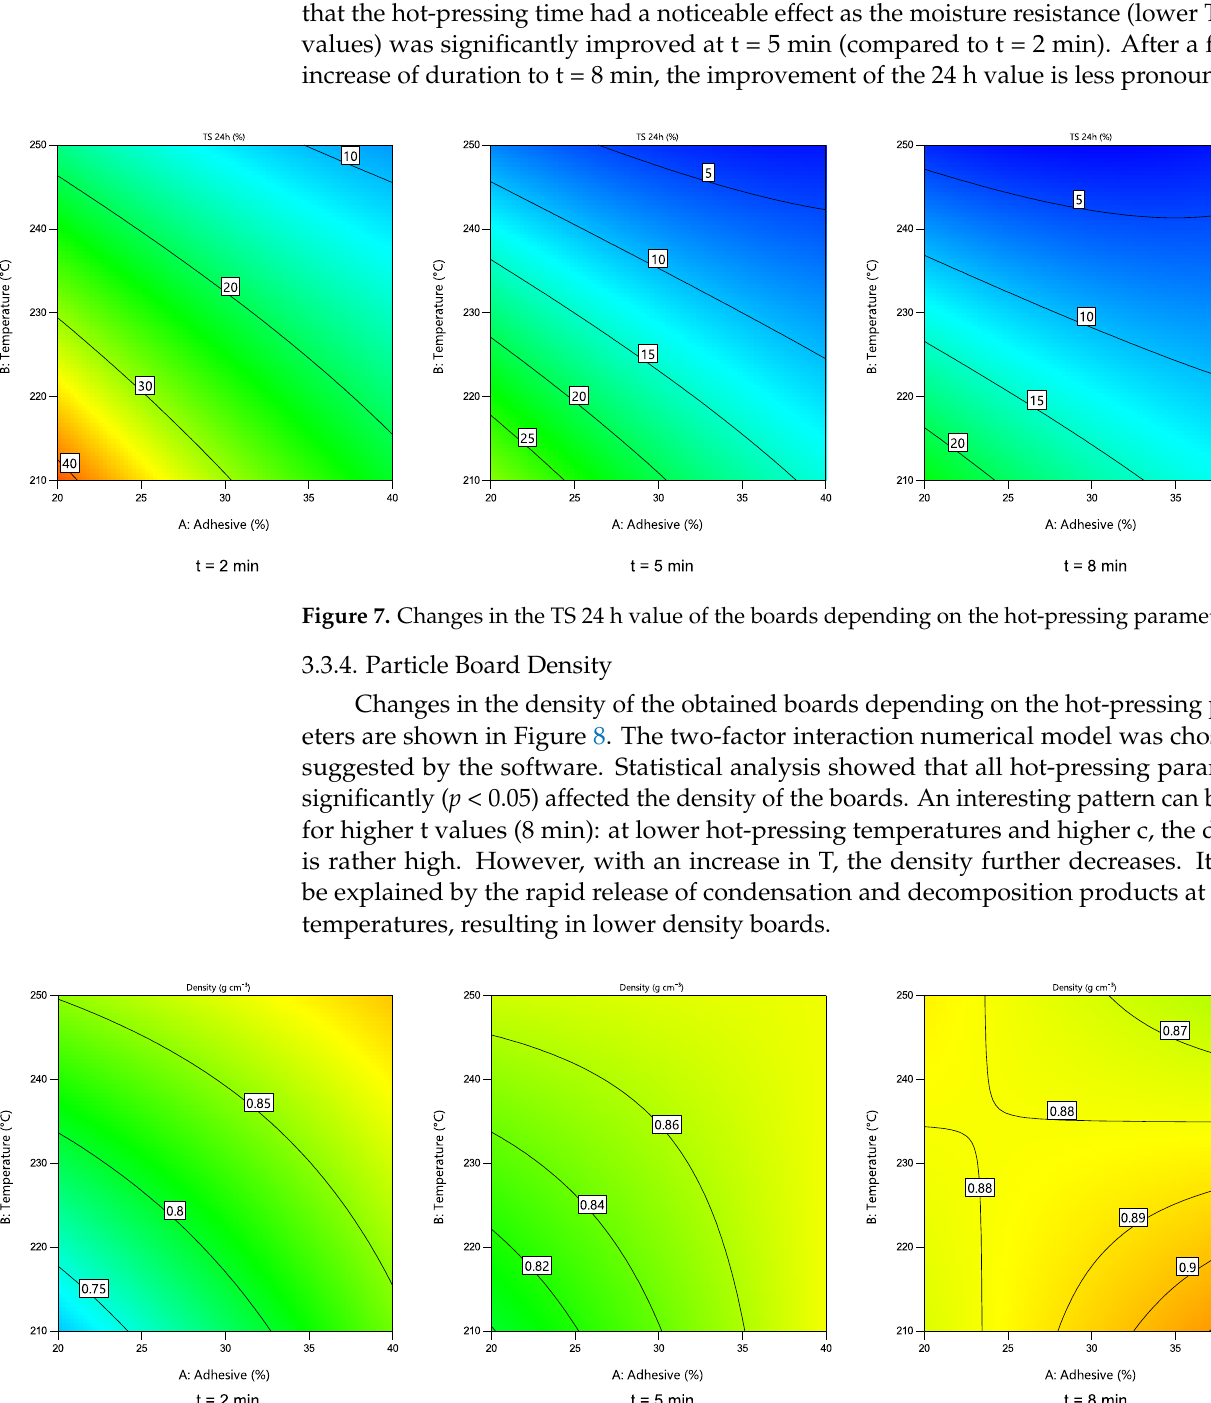
Figure 6. Changes in the MOR value of the boards depending on the hot-pressing parameters.